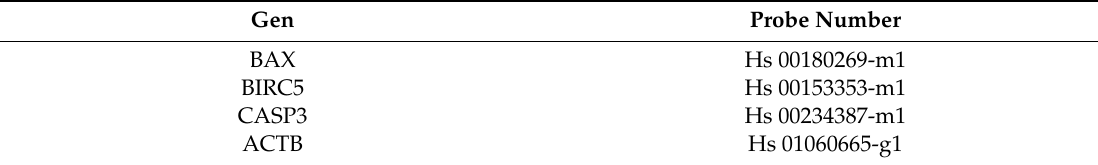
Table 5. Taq Man probes used for REAL-Time PCR